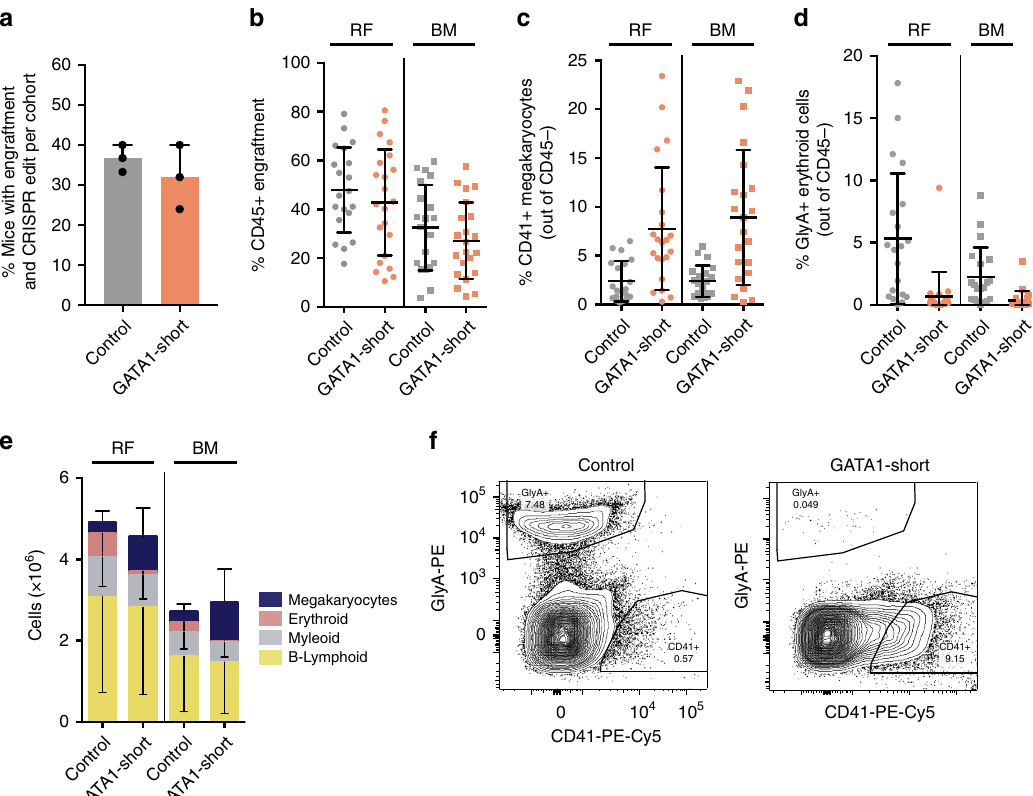
Fig. 4 Functional interrogation of single CRISPR/Cas9-edited hematopoietic stem cells in NSGW41 mice. a Percentage of CRISPR/Cas9 edited LT-HSCs injected NSGW41 mice with engraftment (>5% based on human CD45 + expression in RF) and high CRISPR/Cas9 knockout ef fi ciency (>90% based on PCR and Sanger sequencing) from each of three cohorts ( n = 3 animal cohorts with independent cord blood pools). b Engraftment levels of control and GATA1-short edited LT-HSCs injected NSGW41 mice based on human CD45 + expression in RF and BM. c Percentage of CD41 + CD45 − megakaryocytes of control and GATA1-Short edited LT-HSCs injected NSGW41 mice in RF and BM (unpaired t test P < 0.001 for GATA1-Short versus control for both RF and BM). d Percentage of GlyA + D45 − erythroid cells in control and GATA1-Short edited LT-HSCs injected NSGW41 mice in RF and BM (unpaired t test P < 0.0005 for RF GATA1-Short versus RF control and unpaired t test P < 0.005 for BM GATA1-Short versus BM control). e Total cell numbers of different lineages in control and GATA1-Short edited LT-HSCs injected NSGW41 mice in RF and BM (unpaired t test P < 0.005 for megakaryocytes GATA1-Short versus control for both RF and BM and unpaired t test P < 0.005 for erythroid GATA1-Short versus control for both RF and BM). f Representative fl ow cytometry plots of control and GATA1-Short edited LT-HSCs injected NSGW41 mice in RF showing CD41 + CD45 − megakaryocytes and GlyA + CD45 − erythroid cells. Error bars represent standard